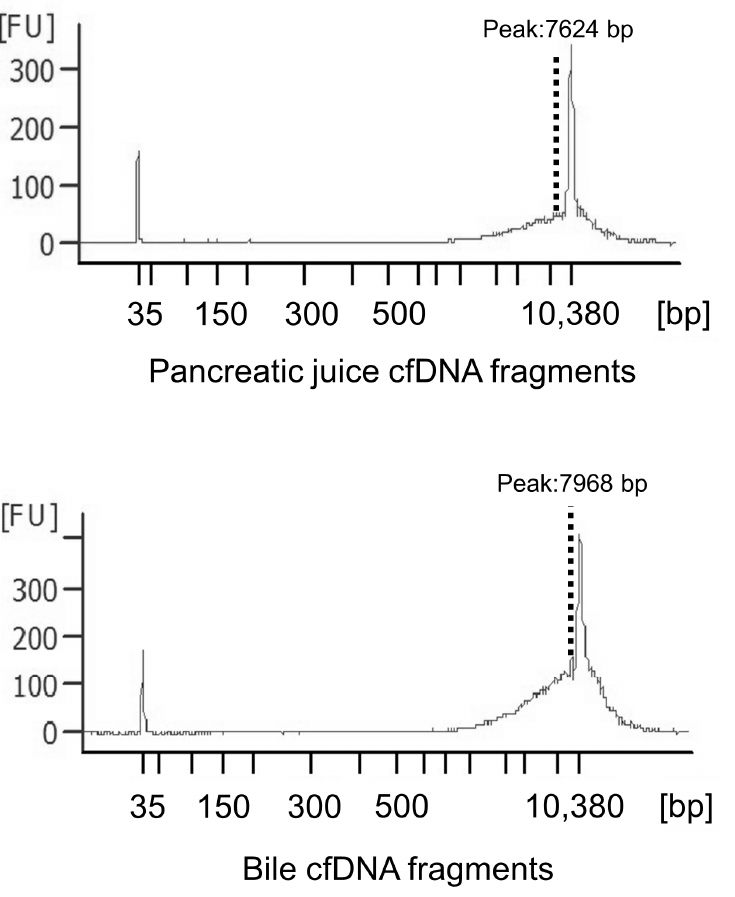
Figure 1. Cell-free DNA (cfDNA) fragment distributions in pancreatic juice and bile. The electoropherograms revealed that all the samples had similar fragment lengths of approximately 8000–10,000 bp.